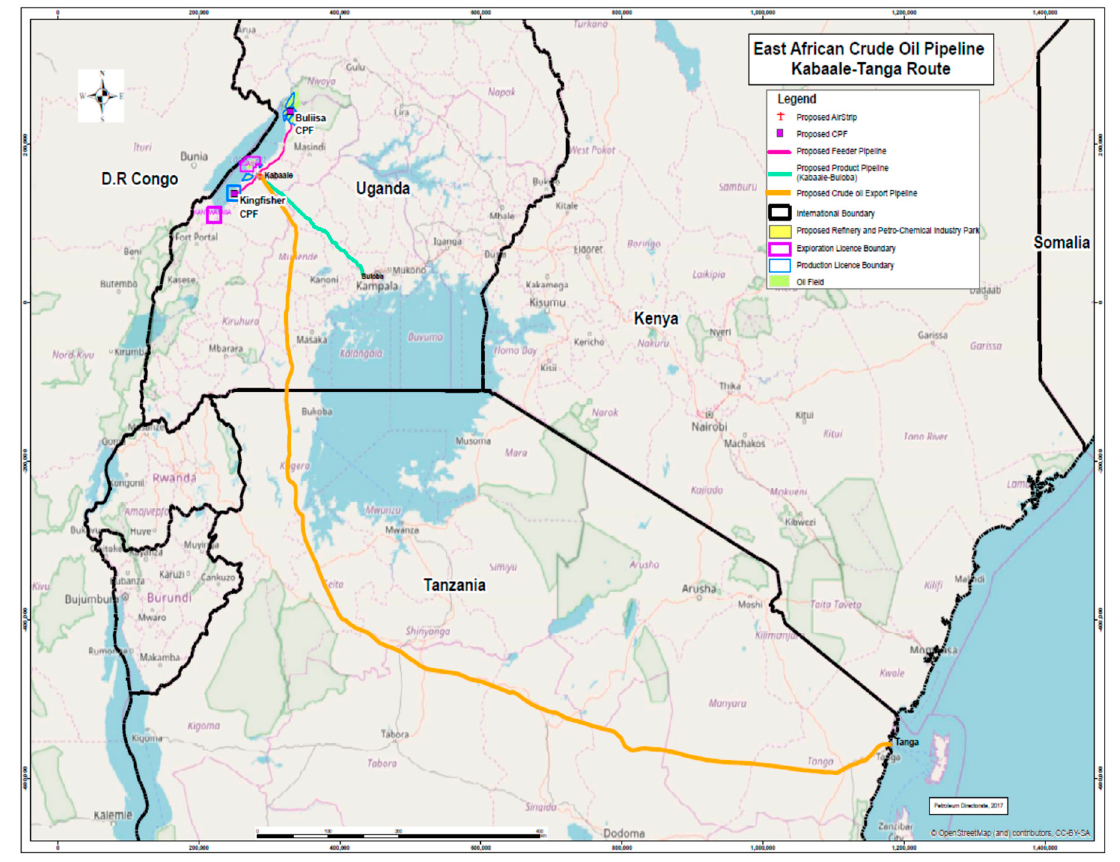
Figure 2. Map of Eastern Africa, showing the approximate location of the pipeline. Source: Petroleum Authority of Uganda (2019), https://pau.go.ug/uploads/EACOP.pdf.